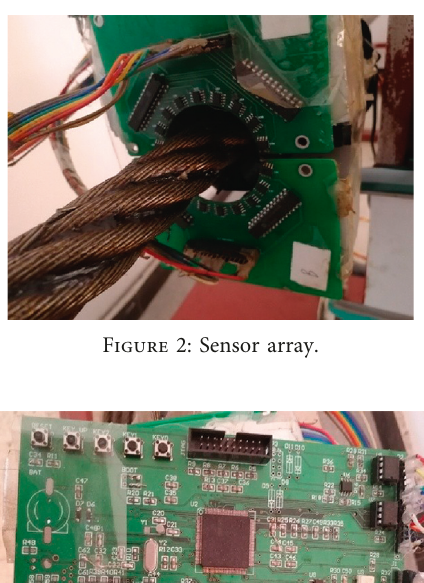
Figure 1: Schematic diagram of the data acquisition device.